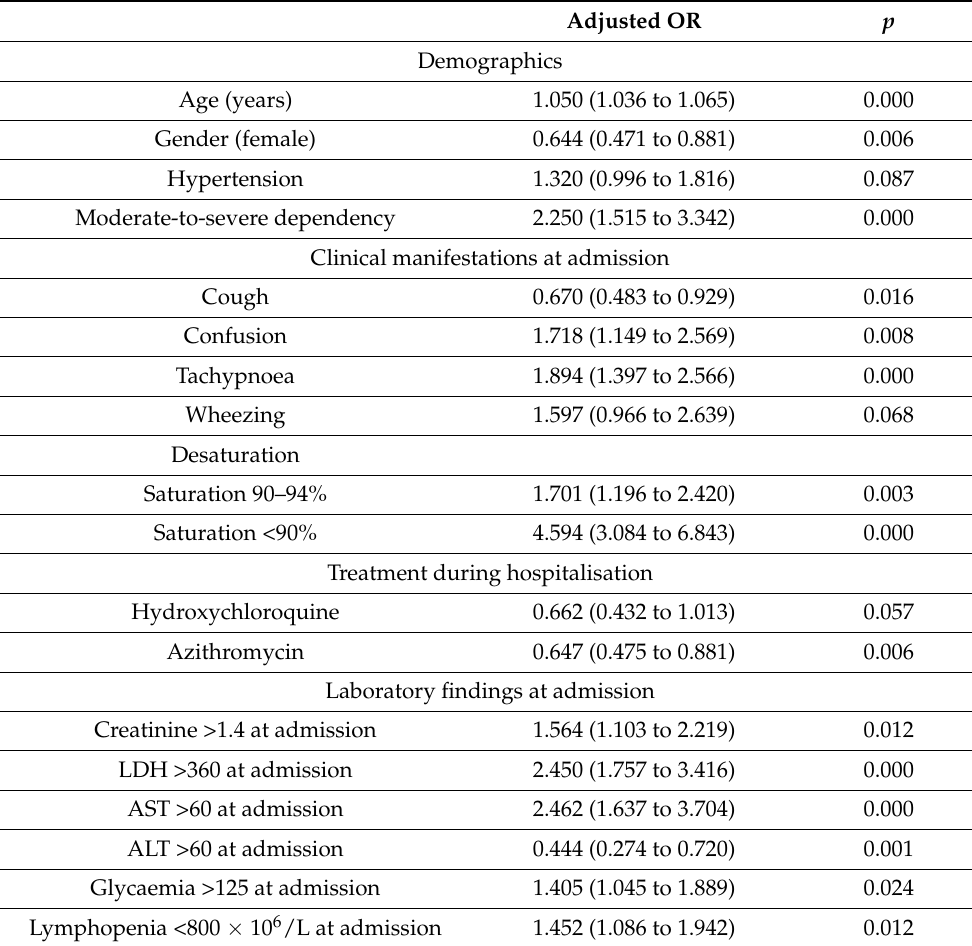
Table 4. Multivariate analysis of mortality. The effect of each factor is expressed as an adjusted odds ratio (CI